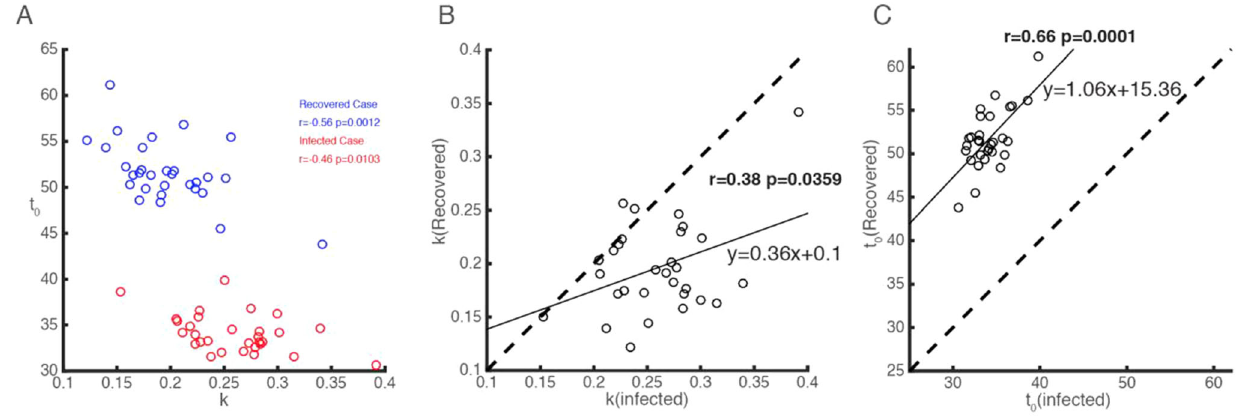
Fig. 3 Relationship between the rules for COVID-19 infected and recovered cases in 30 provinces of China